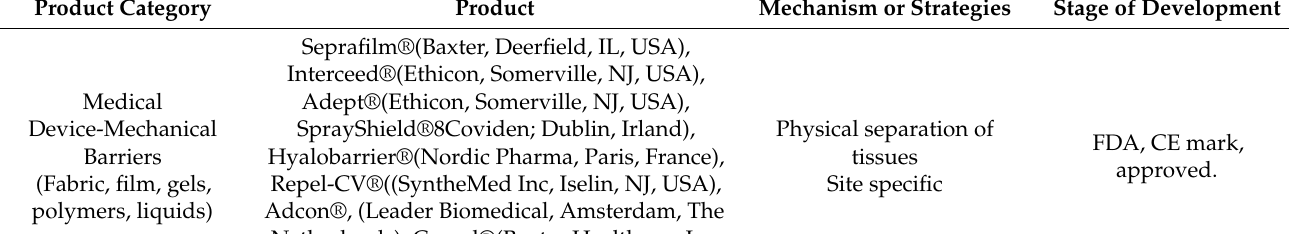
Table 1. Adhesion-preventing products, mechanisms of action and drug/device stage of development.